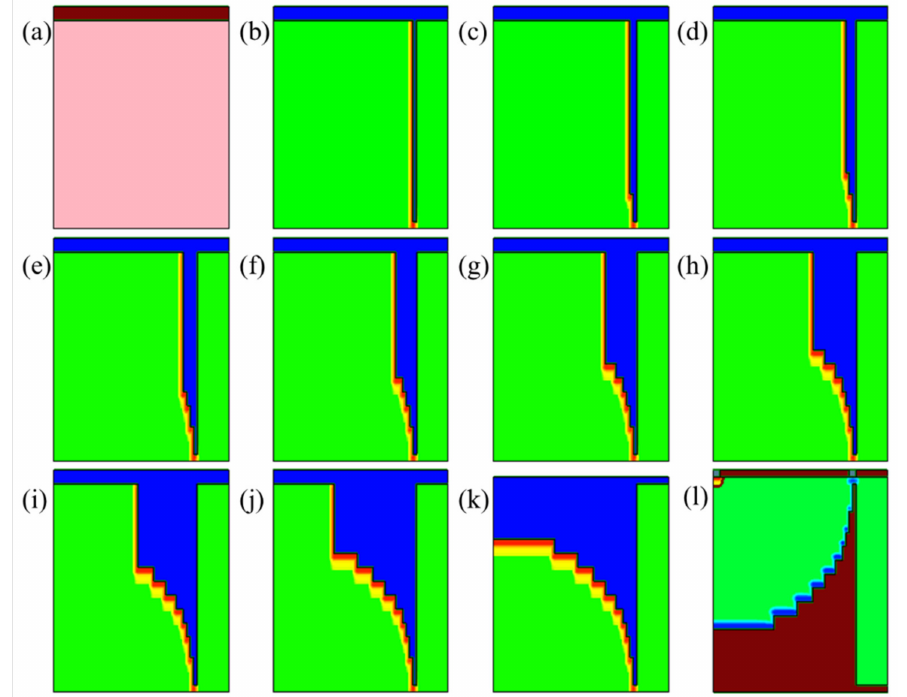
Figure 12. The fabrication process simulation of the hemispherical/near-hemispherical electrode detector ( a – l ).